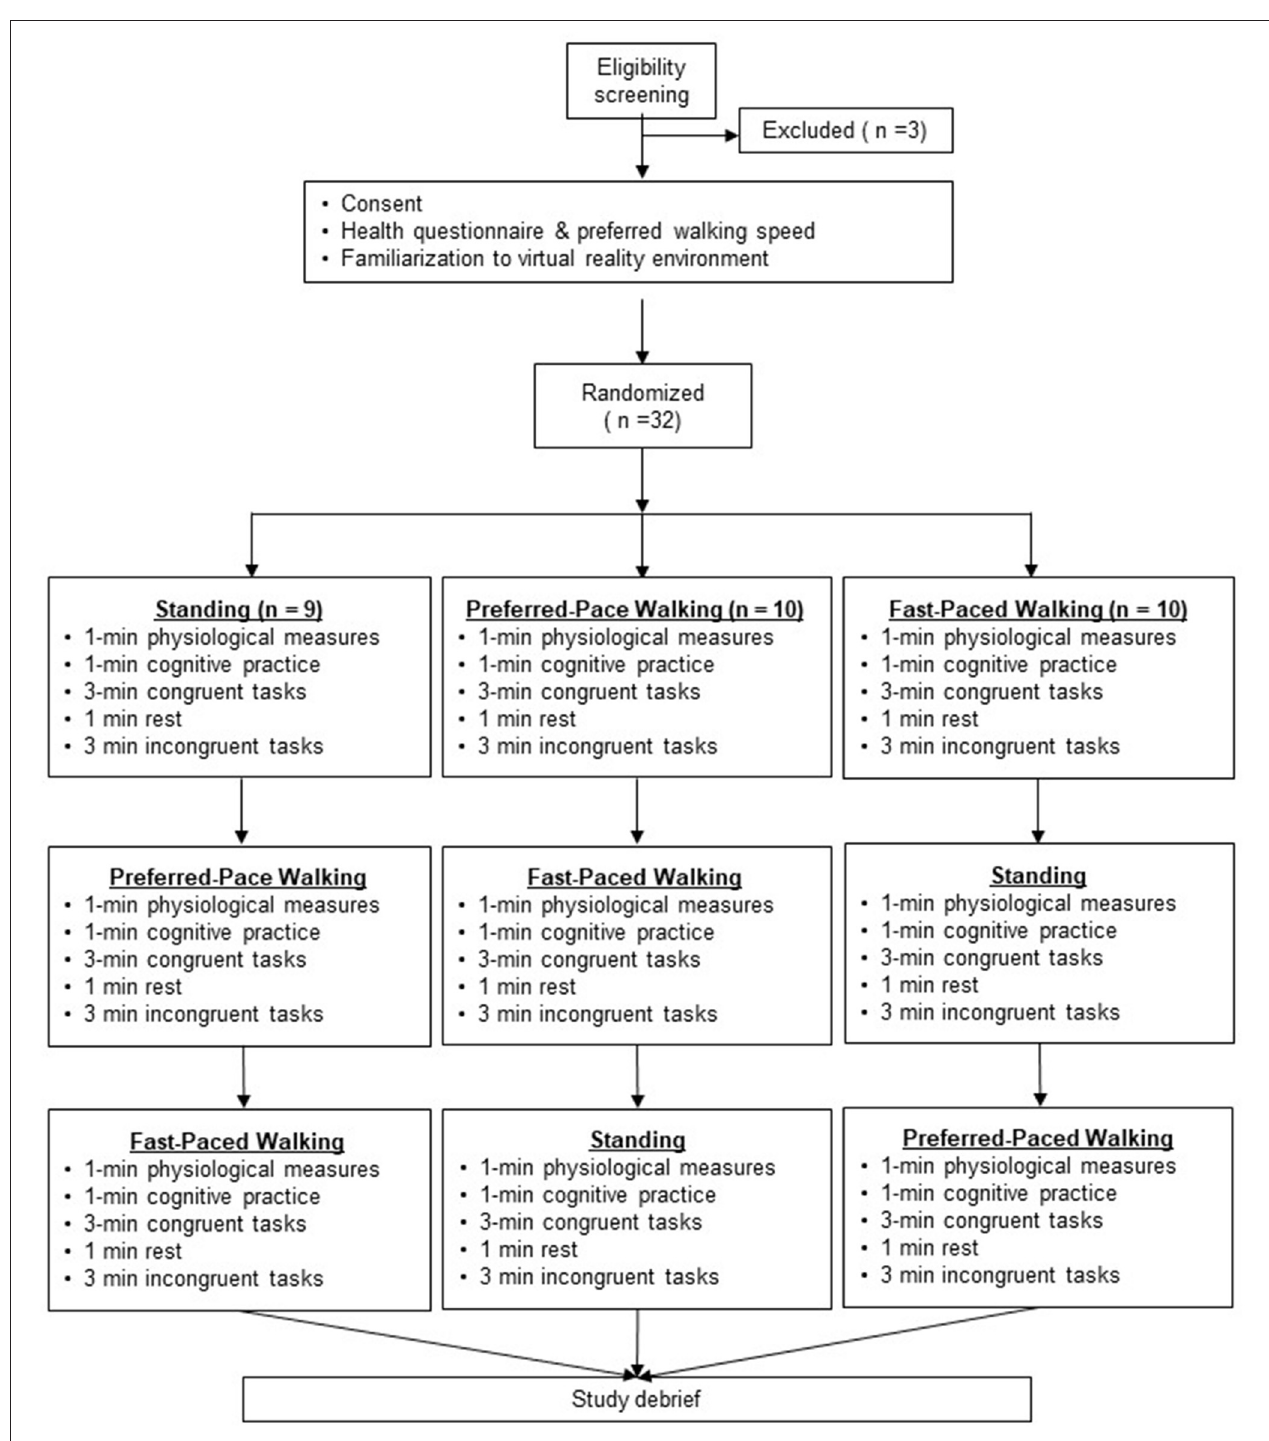
FIGURE 1 | Summary of study protocol and randomization. Cognitive performance was the dependent variable and was quantified by measuring reaction time and error rate. Behavioral